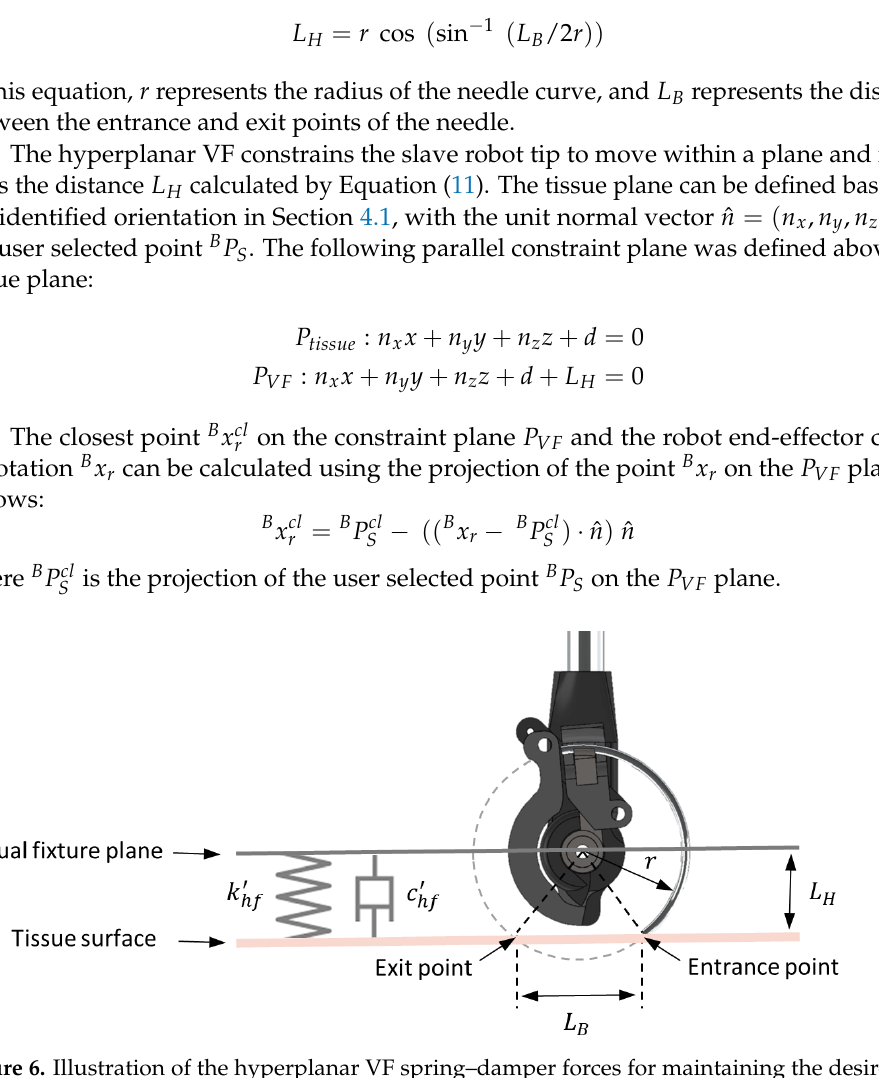
Figure 6. Illustration of the hyperplanar VF spring–damper forces for maintaining the desired L H distance between the needle centre of rotation and tissue surface plane for achieving the selected bite length L B